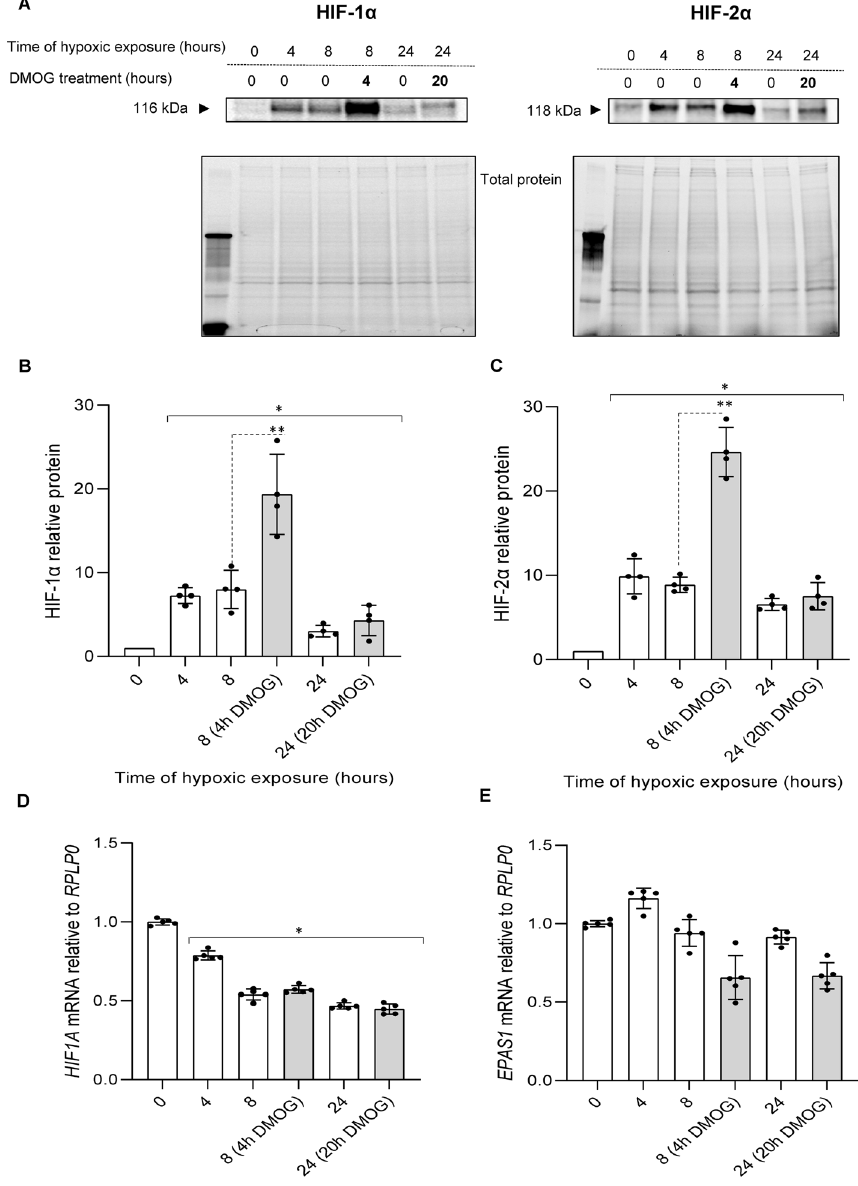
Fig. 5 Inhibition of PHDs activity during hypoxia with DMOG results in accumulation of HIF-1α and HIF-2α in HUVECs. Cells were exposed to hypoxia in the presence or absence of 2.5 mM DMOG that was added (grey bars) after 4 h from the experiments start and for the time periods specified, the total RNA and protein lysates were collected. The changes in HIF-1α and HIF-2α protein levels were evaluated by western blot ( A ) normalized to total protein levels and related to the normoxic control ( B , C ). Data represent the mean SD ± of four independent experiments * P < 0.05 was considered significant. HIF1A and EPAS1 mRNA levels were quantified by qRT-PCR and normalized to RPLP0 mRNA levels and expressed as a fold change over normoxic samples ( D , E ). Data represent the mean SD of five independent experiments (3 replicates each). * P < 0.05 ± was considered As an alternative approach, HUVECs were exposed to hypoxia (1% O 2 ) for 4 h and then O 2 was reduced to 0.3%, and cells remained in these conditions for another 4 h (total time of hypoxic exposure was 8 h). For the 24-h time point, the cells were changed